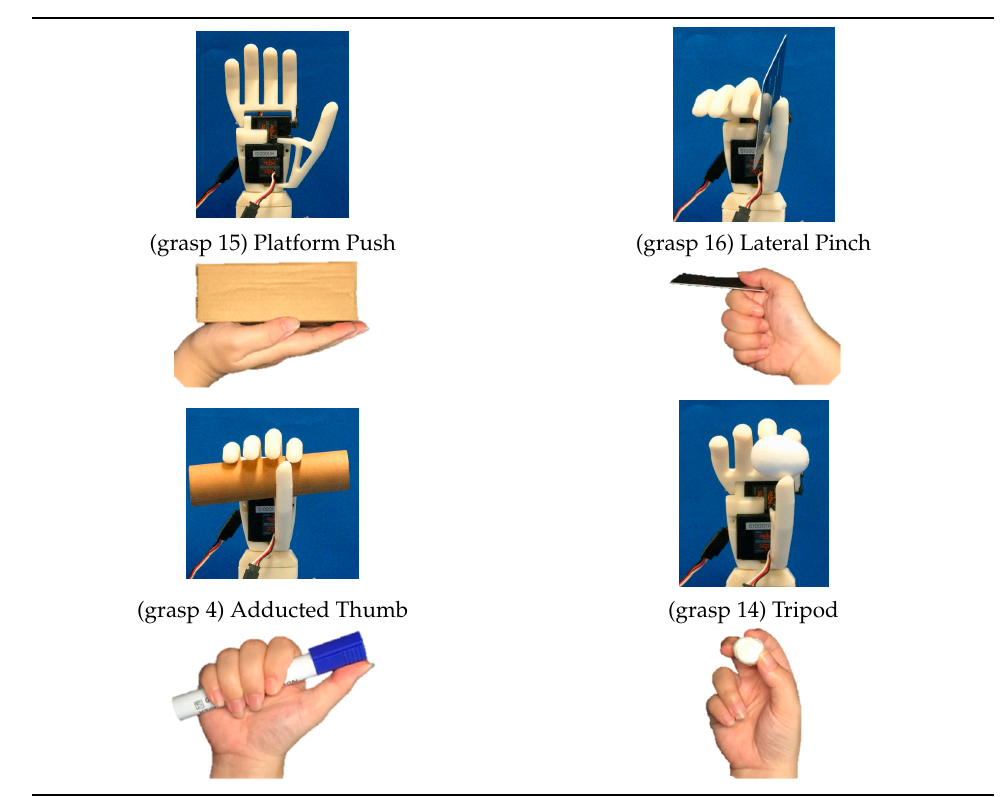
Table 5. Achievable motion types (adaptive linkage type).